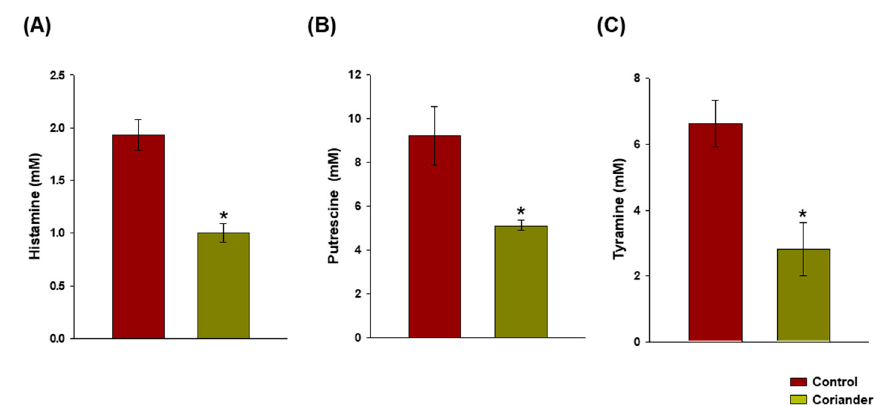
Figure 6. Quantification of biogenic amines, ( A ) histamine, ( B ) putrescine, and ( C ) tyramine, in Korean soy sauce samples prepared by adding coriander during fermentation, compared to those in the control. *: a significant difference at p < 0.05.